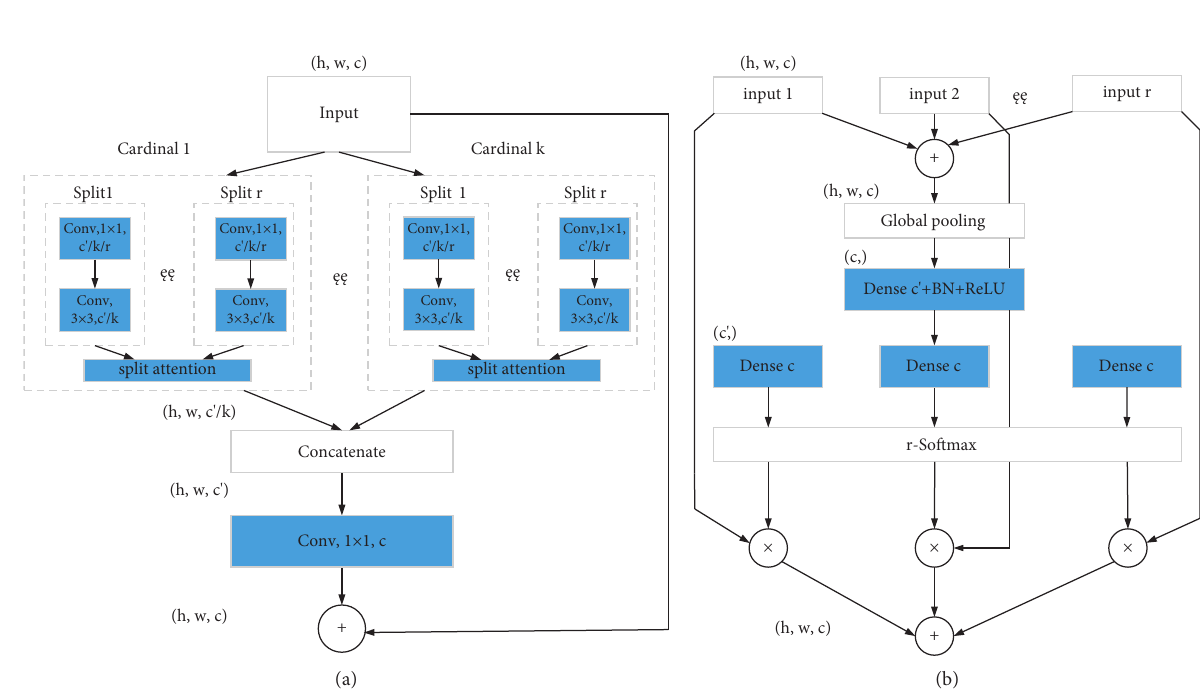
Figure 5: Mask R-CNN model